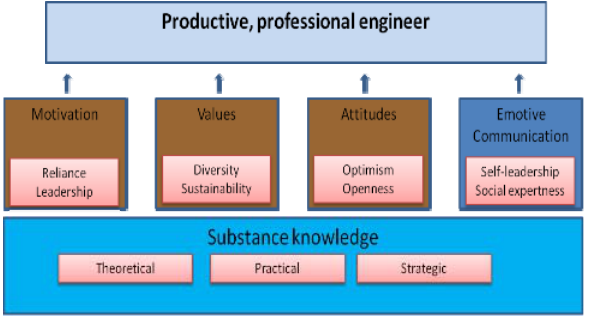
Figure 3. The professional competency of